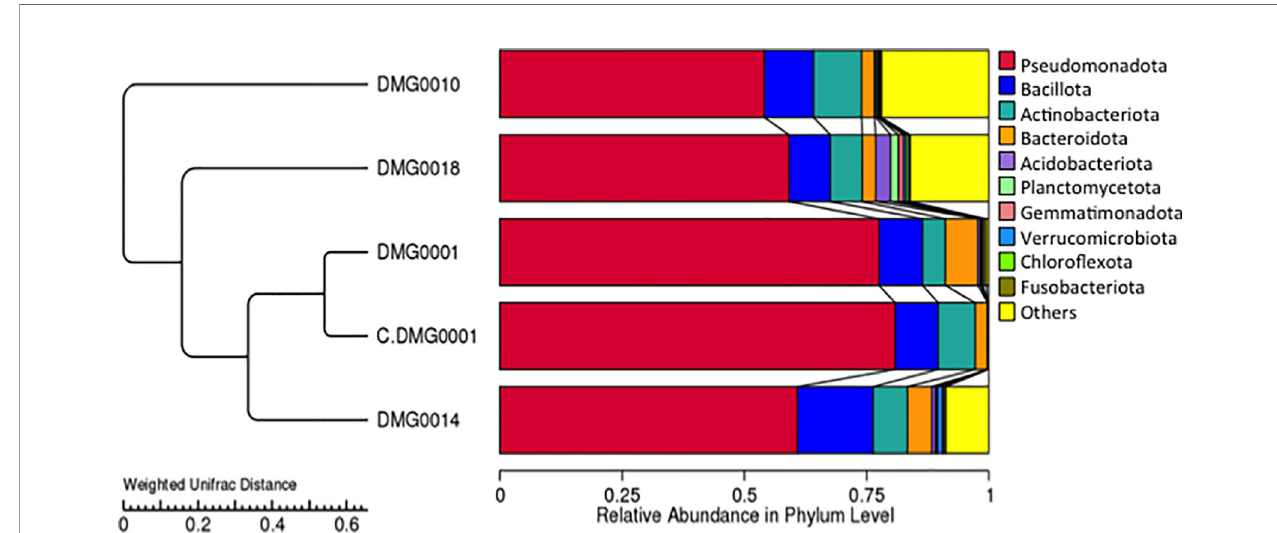
FIGURE 5 | UPGM cluster tree based on Weighted UniFrac distances at the phylum level shows the bacterial micro fl ora is similar between P. hermaphrodita C. DMG0001 (which did not kill slugs) and P. hermaphrodita DMG0001. The microbiome of P. neopapillosa (DMG0014) was closely related to P. hermaphrodita (C. DMG0001 and DMG0001), yet P. californica (DMG0018) shared little in common with bacteria found in P. hermaphrodita/P. neopapillosa clade. The wild strain of P. hermaphrodita DMG0010 was the least similar to the other microbiomes.